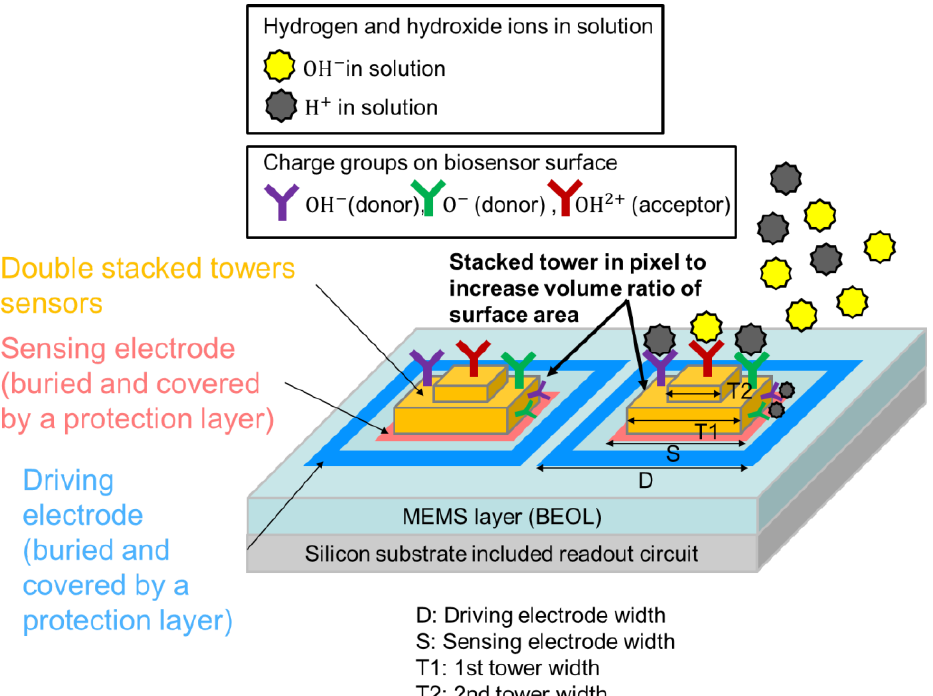
Figure 1. Cross-sectional view of the proposed 3D stacked tower pixels in biosensor array before and after specific ions binding. Charge groups are on the tower surface, and ions hydrogen and hydroxide are in analyte solution.